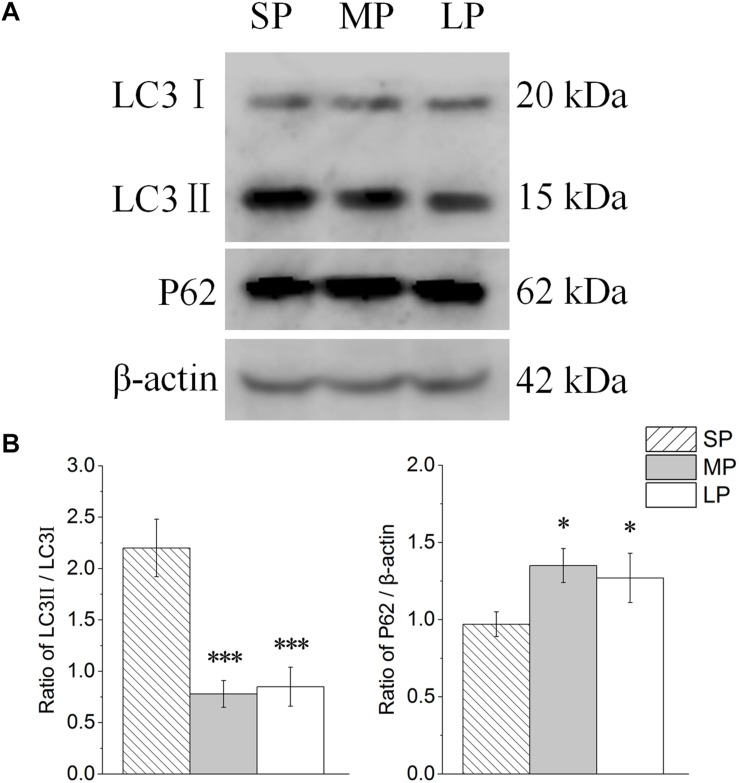
Changes in protein levels of LC3 and P62 in HG of hamsters in three different photoperiodic groups. (A) Representative immunoblots of LC3, P62, and β-actin in three different photoperiodic groups. (B) Ratio of LC3, P62 to β-actin in HG of hamsters in three different photoperiodic groups. Values are means ± SD. n = 10. SP, short photoperiod; MP, moderate photoperiod; LP, long photoperiod. ∗P < 0.05, ∗∗∗P < 0.001 compared with SP; #P < 0.05, ###P < 0.001 compared with MP.